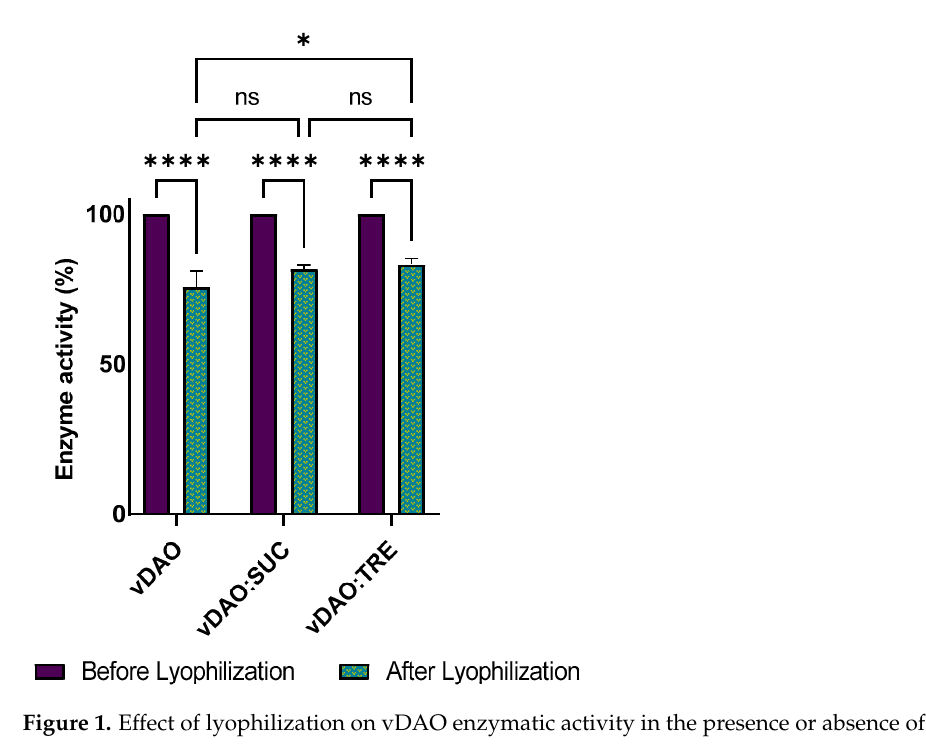
Figure 1. Effect of lyophilization on vDAO enzymatic activity in the presence or absence of sucrose (SUC) or trehalose (TRE) as cryoprotectants. vDAO activity was assayed by the (SUC) or trehalose (TRE) as cryoprotectants. vDAO activity was assayed by the DCHBS-AAP-HRP method. Reported values are the mean ± standard deviation (SD); n =3 different experiments; * p < 0.001, **** p < 0.0001, and ns: not significant; two-way ANOVA multiple comparisons.